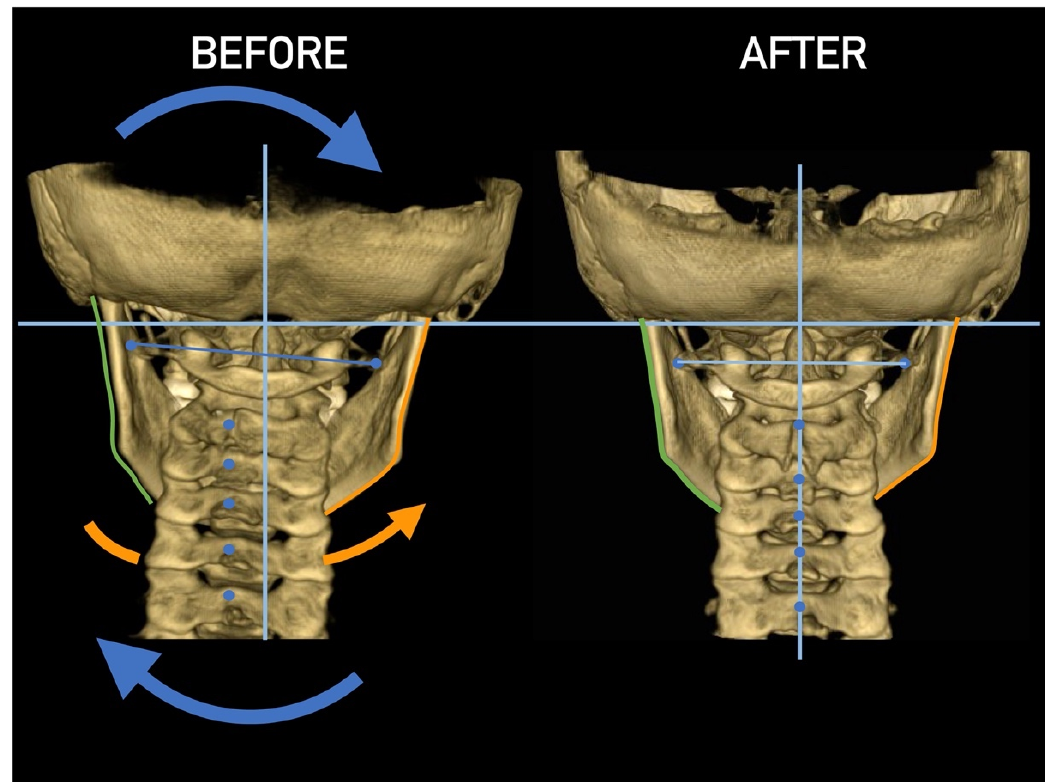
Figure 26. Effect of cervical vertebrae alignment. Posterior view.